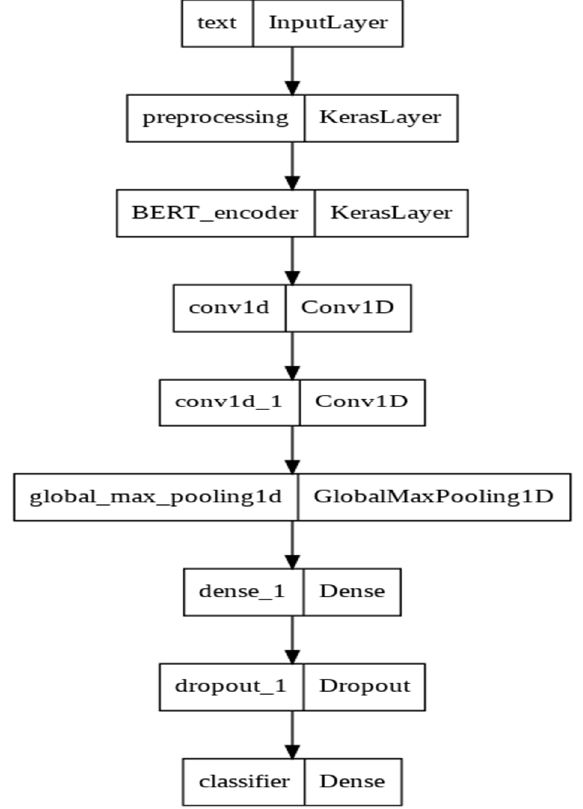
Figure 6. BERT + ANN model architecture.